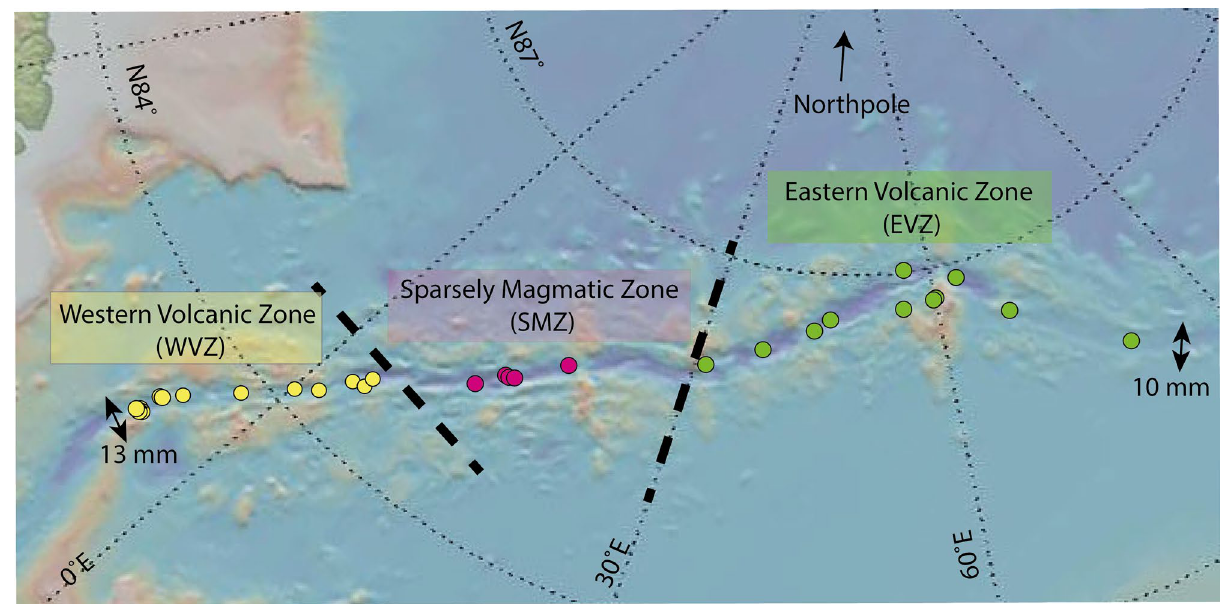
Figure 1. Sample locations. The Gakkel Ridge extends for 1800 km from the Northeast of Greenland to the Northwest of Siberia and can be divided into three different ridge segments—the Western Volcanic Zone (WVZ), the Sparsely Magmatic Zone (SMZ) and the Eastern Volcanic zone (EVZ) 50 . All three segments are highlighted in a different colour (yellow = WVZ; pink = SMZ; light green = EVZ) and are separated by a black dashed line that indicates the local extension of each ridge segment, based on petrological and tectonic observations 50 . The map was made using GeoMapApp (http://www.geoma